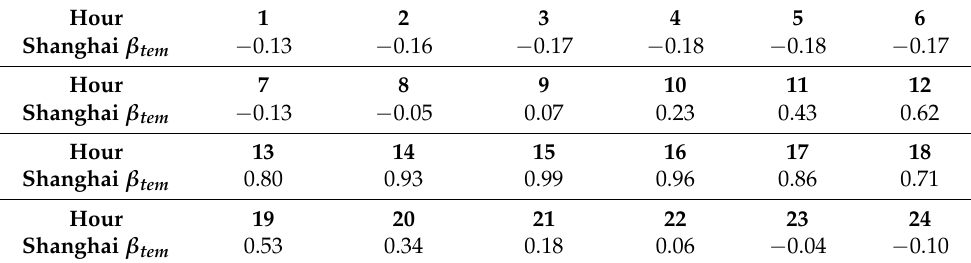
Table 5. Hourly variation coefficient of dry bulb temperature in Shanghai.